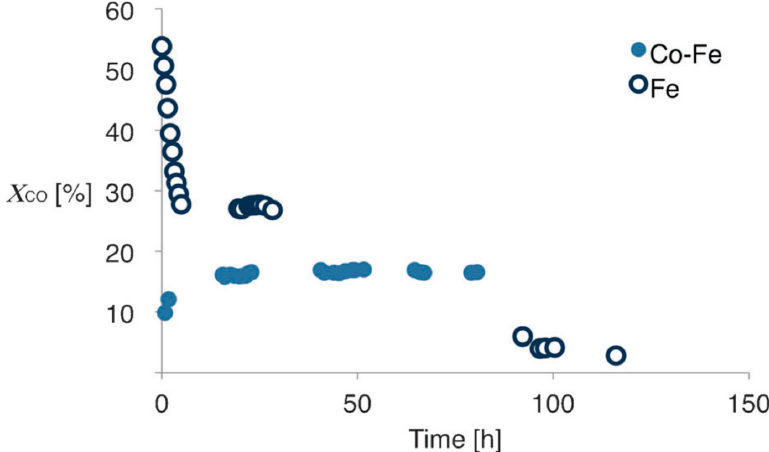
Figure 9. Catalytic activity expressed in terms of CO conversion. Reprinted with permission from [77]. Copyright (2013) Wiley-VCH Verlag GMBH, Weinheim, Germany .